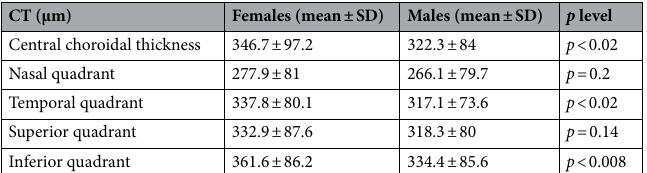
Table 3. CT results in females and males.